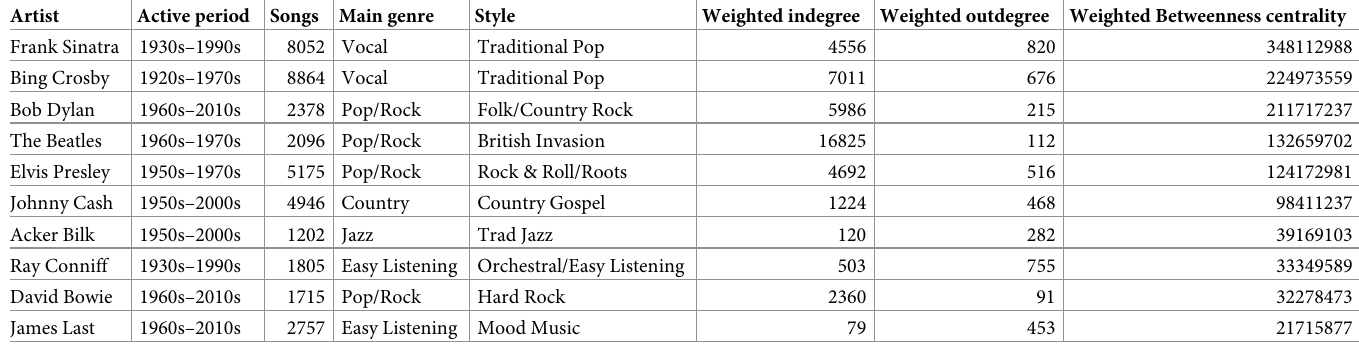
Table 4. Top 10 artists by weighted betweenness centrality. Artist